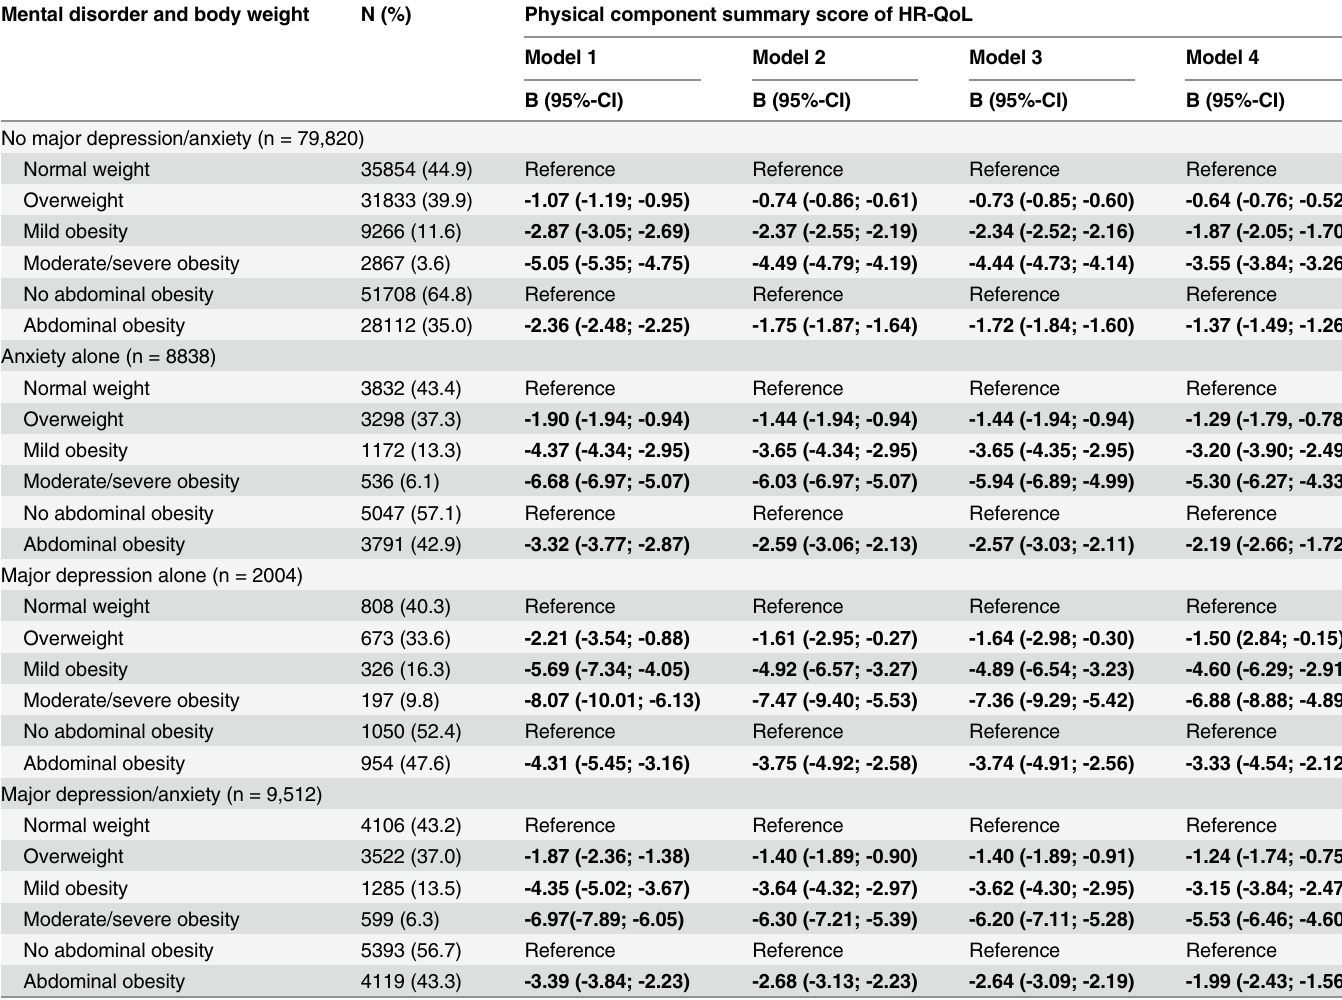
Table 4. Crude and adjusted regression coefficients (B) for physical quality of life with general and abdominal obesity categories, stratified by major